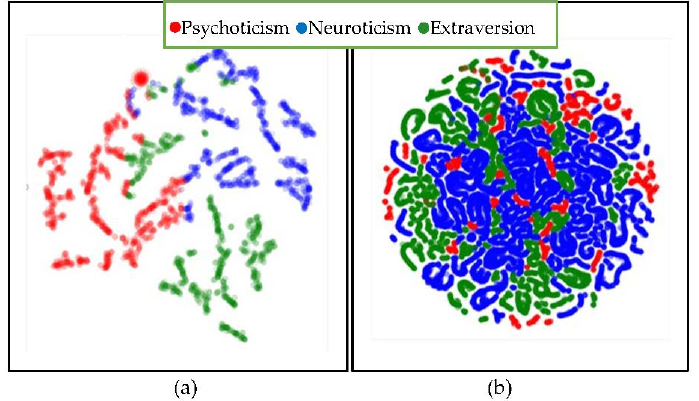
Figure 5. t-SNE visualization for multiclass distribution of myPersonality ( a ) and Sentiment140 ( b ).